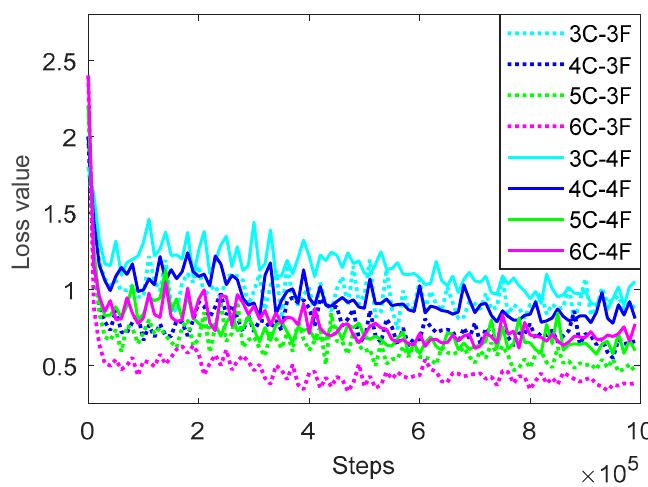
Figure 7. Loss value of CNN with different layers using the training set.